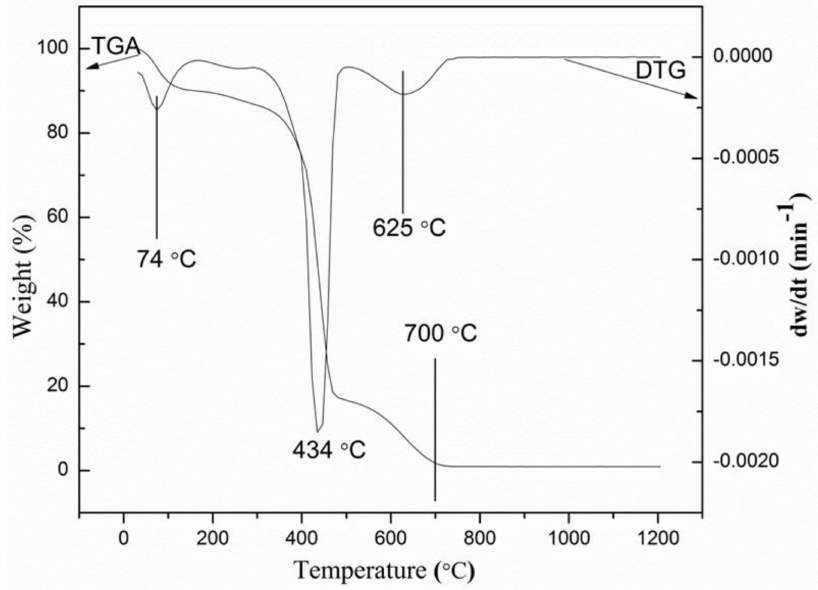
Figure 1. Thermogravimetric (TG) and thermogravimetric derivative (DTG) curves for PVP at a heating rate of 10 ◦